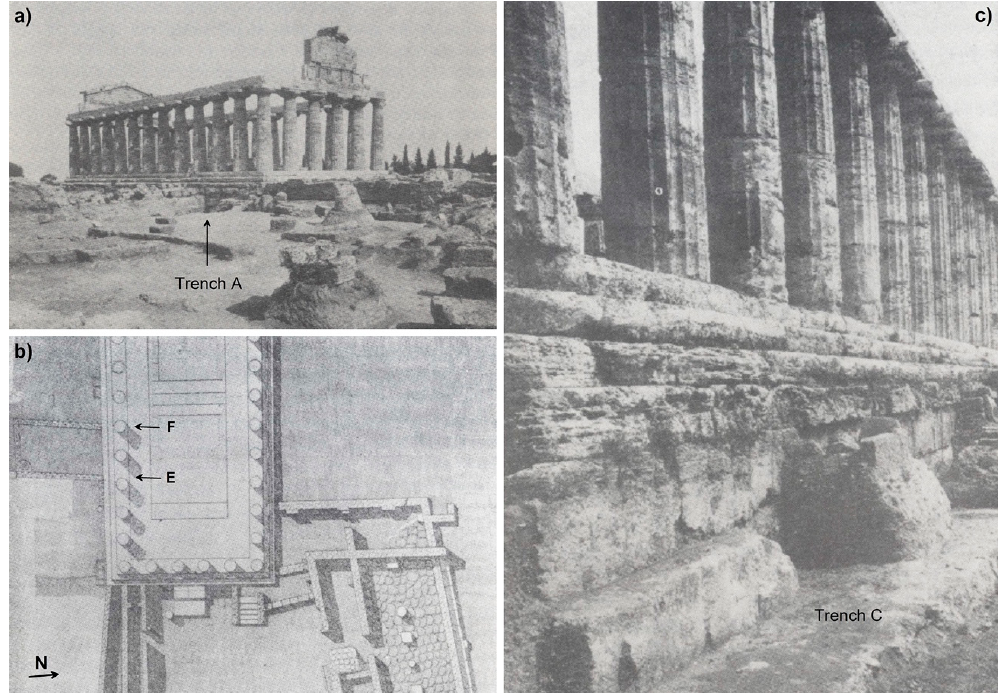
Figure 15. The southeast side of the temple with the trench between the first and third columns (Trench A) (( a ): photo E. Samaritani, 1937), dug during the excavations carried out between 1928 and 1939 (( b ): a sketch of Maiuri’s excavations), and excavation along the foundations of the south side (Trench C) (( c ): photo E. Samaritani,